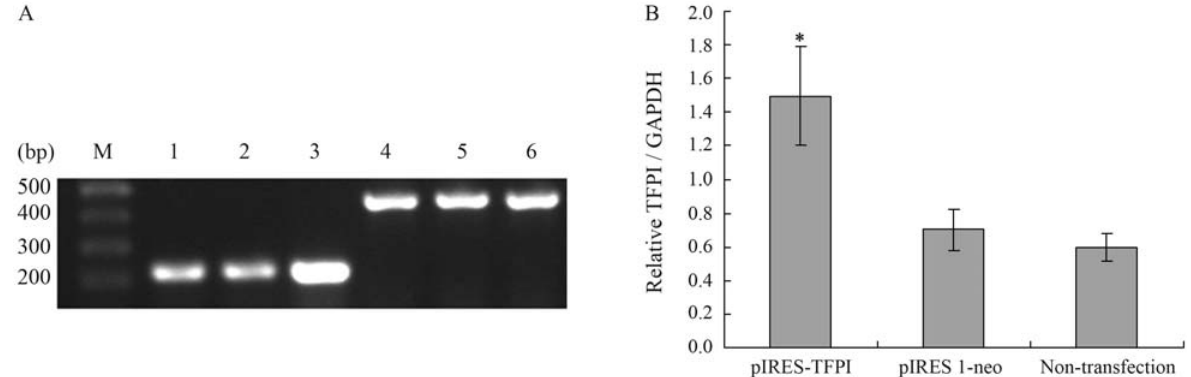
Figure 1 - Analysis of RT-PCR amplification of TFPI by agarose gel electrophoresis. (A) M: DNA maker; 1: TFPI amplification in the non-transfection group; 2: TFPI amplification in pIRES 1-neo group; 3: TFPI amplification in the pIRES-TFPI group; 4: GAPDH amplification in the non-transfection group; 5: GAPDH amplification in the pIRES 1-neo group; 6: GAPDH amplification in the pIRES-TFPI group. (B) TFPI mRNA levels standardized by GAPDH. * p < 0.05 as compared to the pIRES 1-neo or non-transfection group (n =